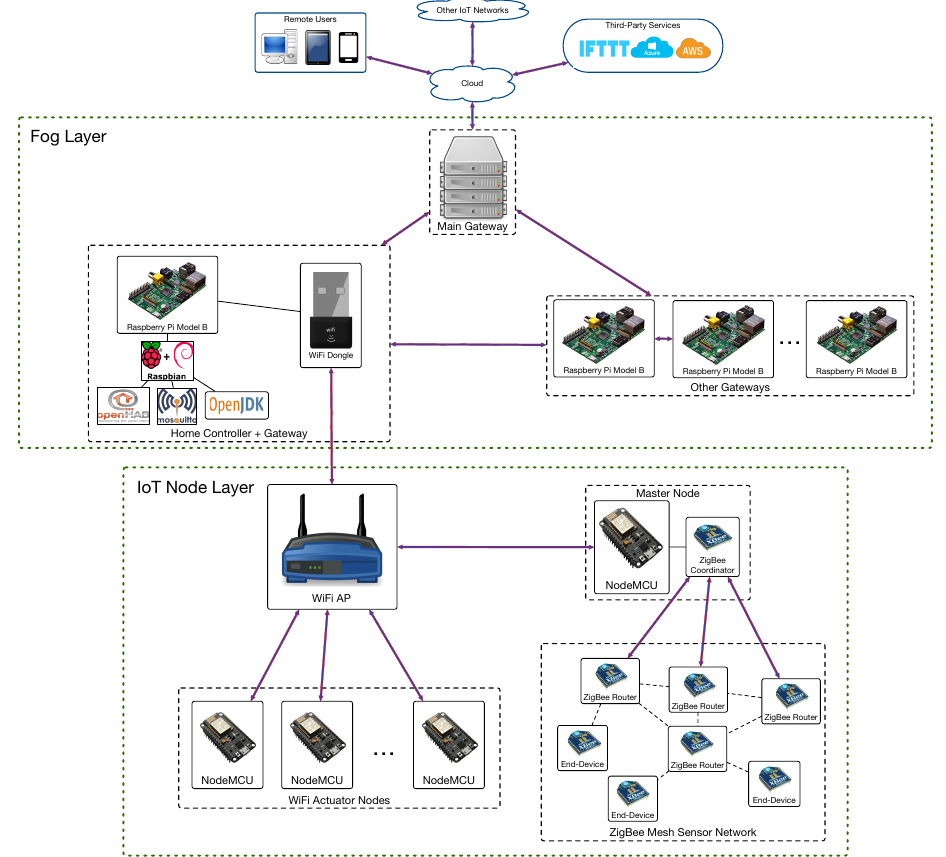
Figure 4. Implemented communications